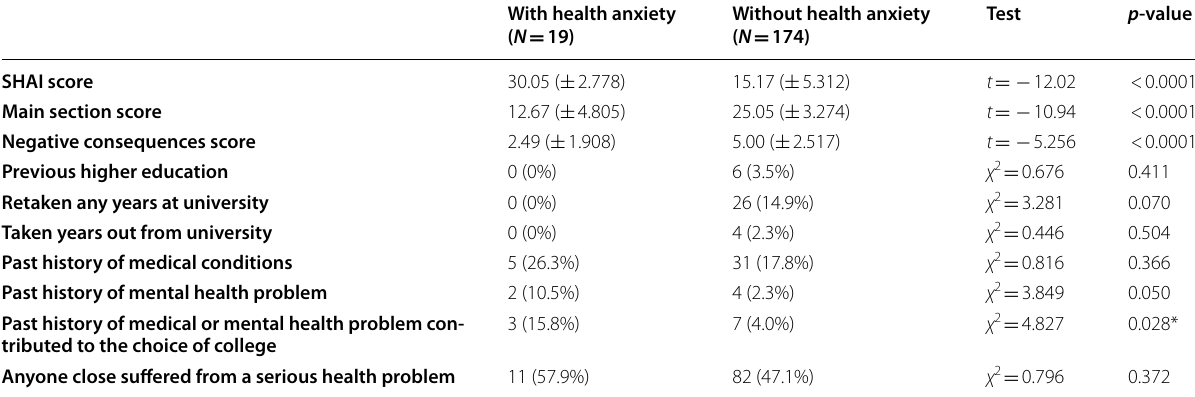
Table 3 Factors predicting the occurrence of health anxiety